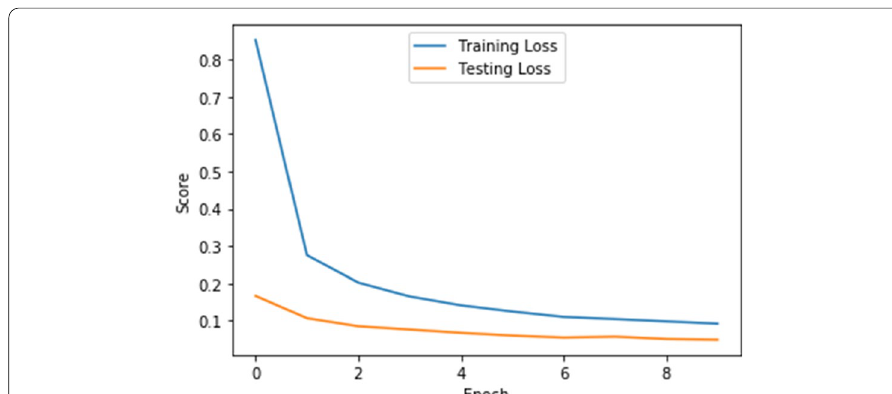
Fig. 8 Training and testing losses